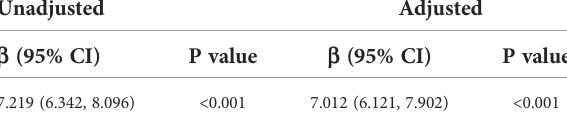
TABLE 3 Linear regression between pre-pregnancy BMI (kg/m 2 ) and birthweight a . Unadjusted